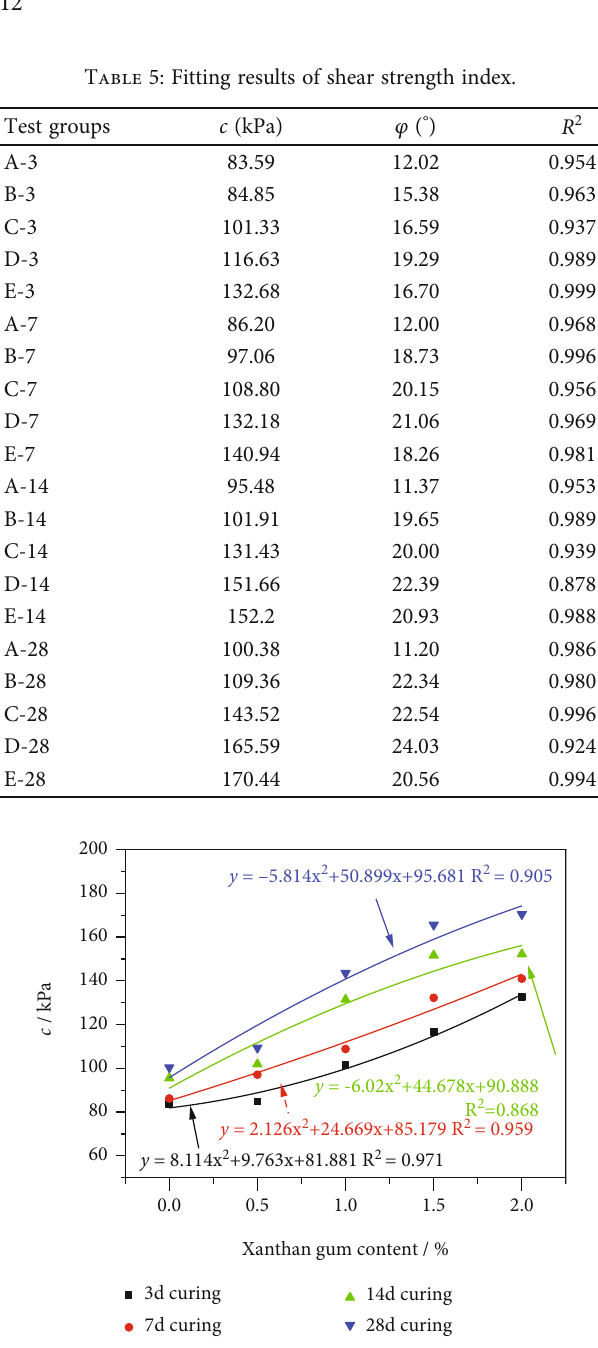
Figure 12: Relationship between xanthan gum content and cohesion.